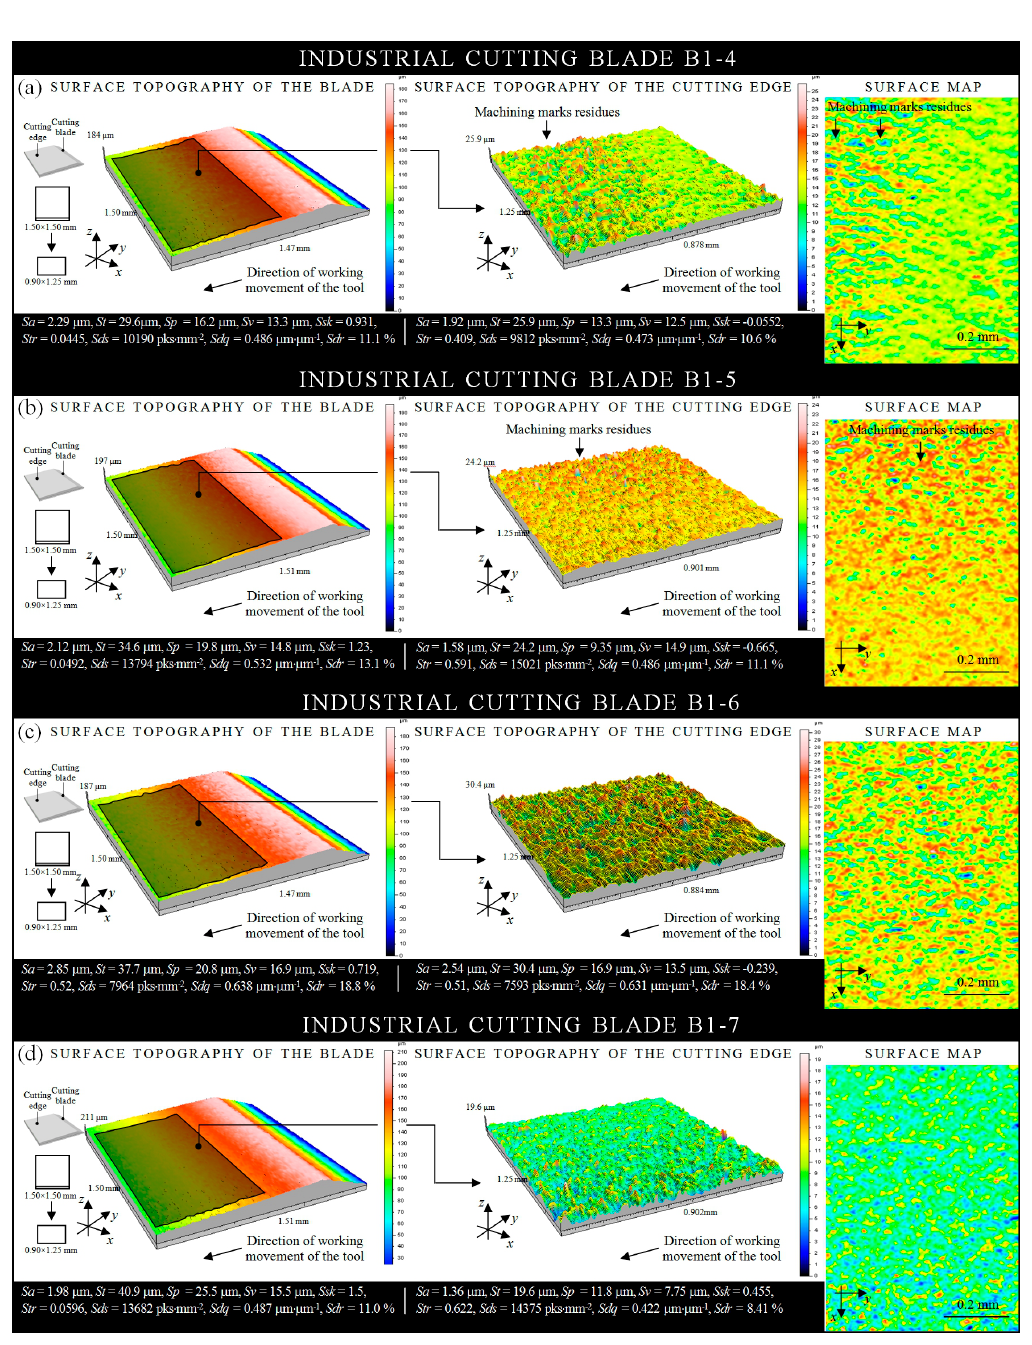
Figure 9. Collection of results of measurements obtained by the use of multisensory optical profilometer Taylor-Hobson Talysurf CLI 2000 for surfaces of low-stiffness planar industrial cutting blades regenerated by the precision grinding process (front grinding) realized in a 5-axis CNC grinding machine: ( a ) Sample B1-4 ( v w = 400 mm / min, n s = 38,000 min − 1 ); ( b ) sample B1-5 ( v w = 450 mm / min, n s = 38,000 min − 1 ); ( c ) sample B1-6 ( v w = 500 mm / min, n s = 38,000 min − 1 ); ( d ) sample B1-7 ( v w = 700 mm / min, n s = 38,000 min − 1 ).